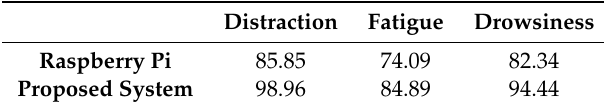
Table 6. Accuracy of the driver status recognition.